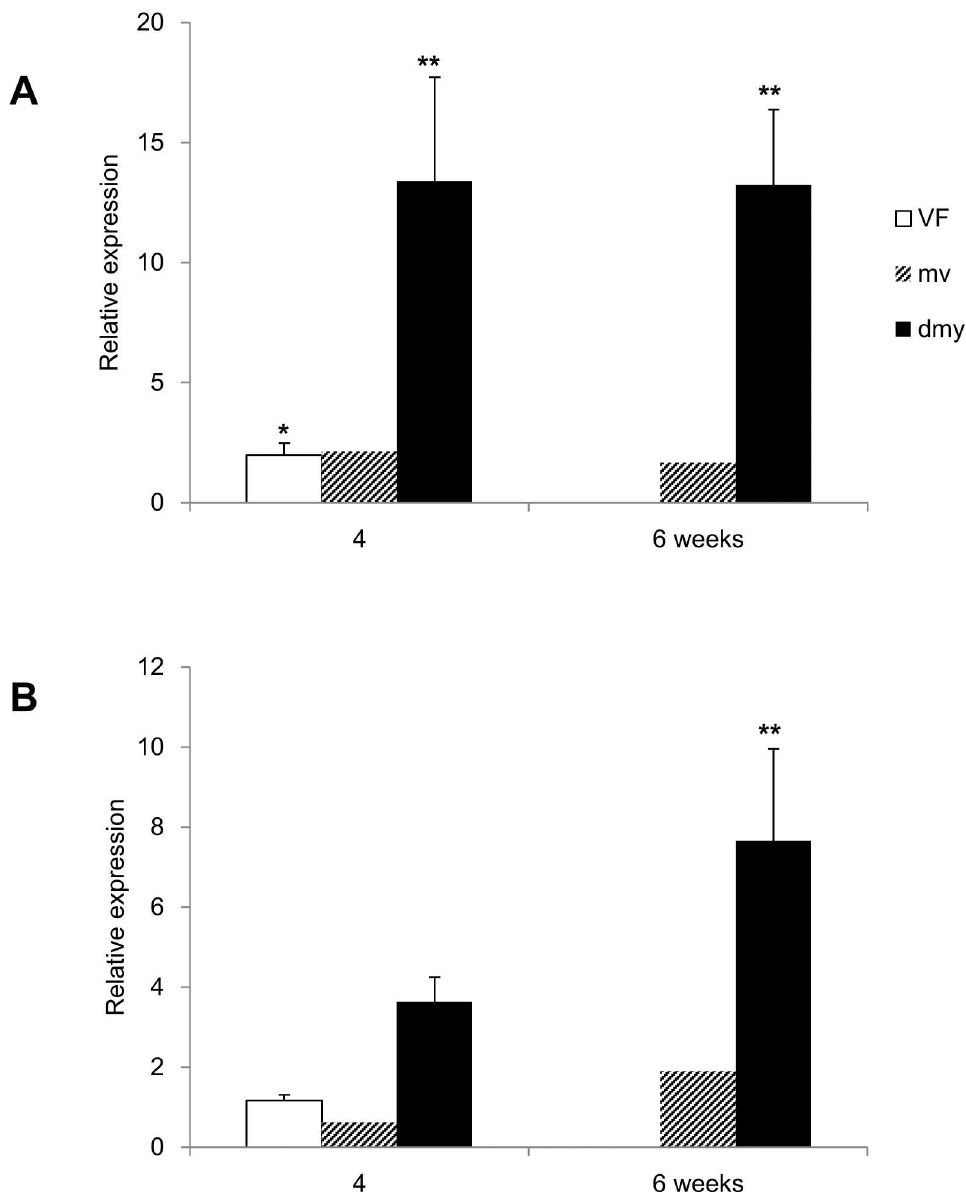
Fig 2. Real-time PCR for Trib3 (VF, mv and dmy rats). Relativeexpressionof Trib3 in the white matter (A) and the gray matter (B) of the cervical spinal cords from the dmy , mv and VF rats by the real-time PCR. The data are presentedas the mean ratio againstexpressionin the control rats. Althoughexpressionlevels of Trib3 mRNA is significantly increasedin the dmy rats, no significantdifferences are seen in the VF and mv rats. * , p < 0.05, ** , p < 0.01, Tukey-Kramer test ( n = 3 in VF and dmy rats. n = 2 in mv